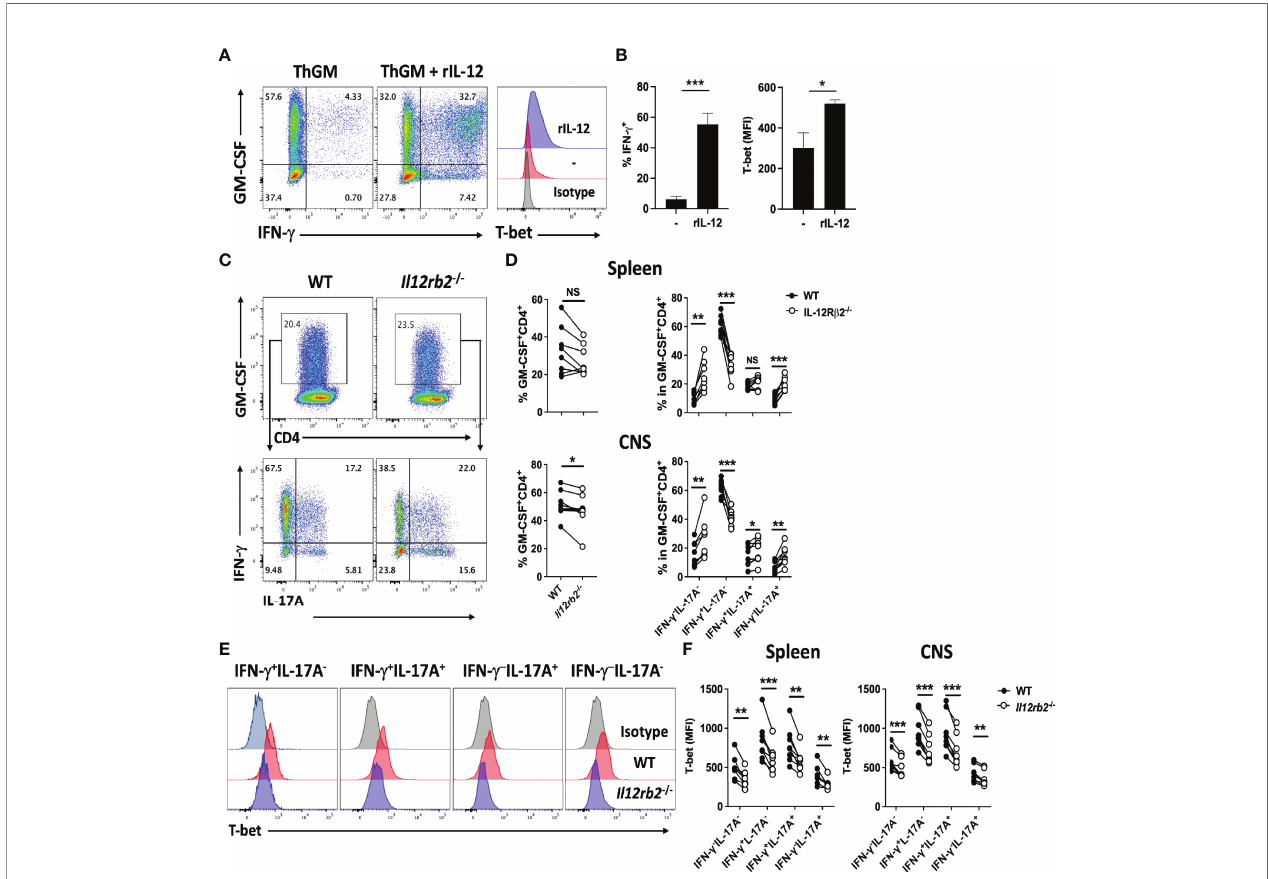
FIGURE 1 | IL-12 induces T-bet expression in ThGM cells. WT naïve CD4 + T cells were differentiated into ThGM cells in vitro and treated with IL-12 in the second stimulation. (A) Representative fl ow cytometry dot plots showing GM-CSF, IFN- g , and T-bet expression by ThGM cells after IL-12 treatment. (B) Proportions (%) of Th1- like cells after IL-12 treatment (left graph). Mean fl uorescent intensity (MFI) of T-bet expression after IL-12 treatment (right graph). (C) WT (CD45.1) and Il12rb2 -/- (CD45.2) CD4 + T cells were transferred into Rag1 -/- mice (n = 8). Recipient mice were immunized for EAE induction, and cells obtained from the spleen and CNS were analyzed at the peak of disease. Representative fl ow cytometry dot plots showing GM-CSF, IFN- g , and IL-17A expression by WT and Il12rb2 -/- CD4 + T cells in the spleen of mice with EAE. (D) Proportions (%) of GM-CSF + cells among WT and Il12rb2 -/- CD4 + T cells analyzed in the spleen and CNS mice with EAE. Proportions (%) of different Th lineages in WT and Il12rb2 -/- GM-CSF + CD4 + T cells analyzed in (D). (E) Representative histograms showing T-bet expression by different Th lineages in WT and Il12rb2 -/- GM-CSF + CD4 + in the CNS. (F) MFI for T-bet expression by different Th lineages in WT and Il12rb2 -/- GM-CSF + CD4 + in the spleen and CNS. Data shown are mean ± SEM. P-values were calculated using unpaired Student ’ s t-test (A, B) and paired Student ’ s t-test with Bonferroni ’ s multiple comparison (C – F) ; *p < 0.05, **p < 0.01, ***p < 0.001, NS, not signi fi